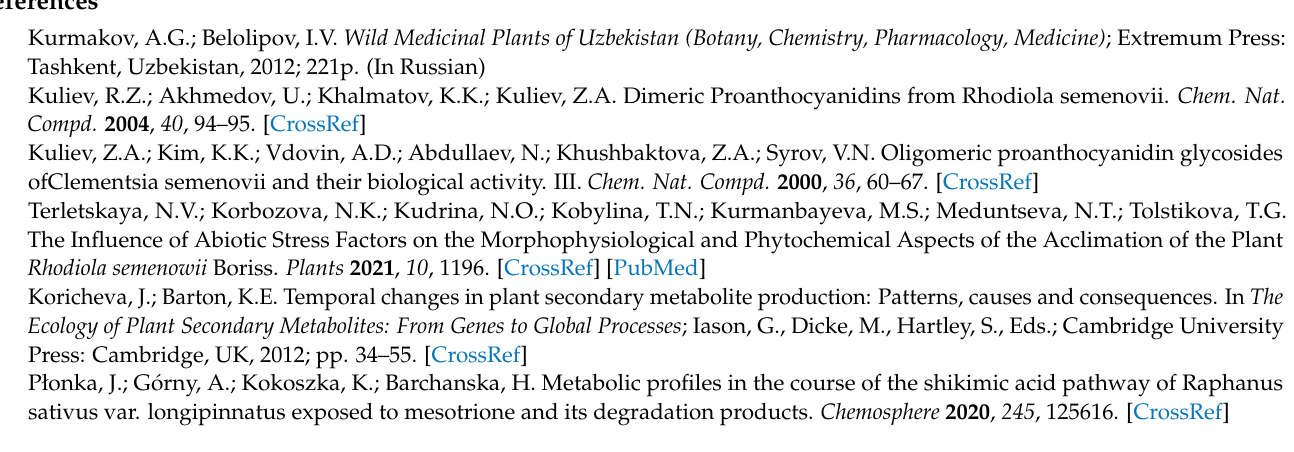
Chromatogram of immature plants extract (roots of R. semenovii ), Figure S2: Chromatogram of immature plants extract (shoots of R. semenovii ), Table S2: Content of SM in flowering plants of R. semenovii , Figure S3: Chromatogram of flowering plants extract (roots of R. semenovii ), Figure S4: Chromatogram of flowering plants extract (shoots of R. semenovii ), Figure S5: Chromatogram of flowering plant extract (flowers of R. semenovii ), Table S3: Content of SM in ripening of seeds of R. semenovii , Figure S6: Chromatogram of adult plants extract (roots of R. semenovii ), Figure S7: Chromatogram of adult plants extract (shoots of R. semenovii ), Figure S8: Chromatogram of tyrosol calibration solution-3 (220nm), Figure S9: Determination of salidroside content in the shoot of an immature plants of R. semenovii , Figure S10: Determination of salidroside content in the root of an immature plants of R. semenovii, Figure S11: Chromatogram of tyrosol calibration solution (280nm), Figure S12: Determination of salidroside content during the flowering in the shoot of the plants of R. semenovii, Figure S13: Chromatogram of tyrosol calibration solution-2 (220nm), Figure S14: Determination of salidroside content during the flowering in the root of the plants of R. semenovii , Figure S15: Determination of salidroside content during ripening of seeds in the shoot of the plants of R. semenovii , Figure S16: Determination of salidroside content during ripening of seeds in the root of the plants of R. semenovii